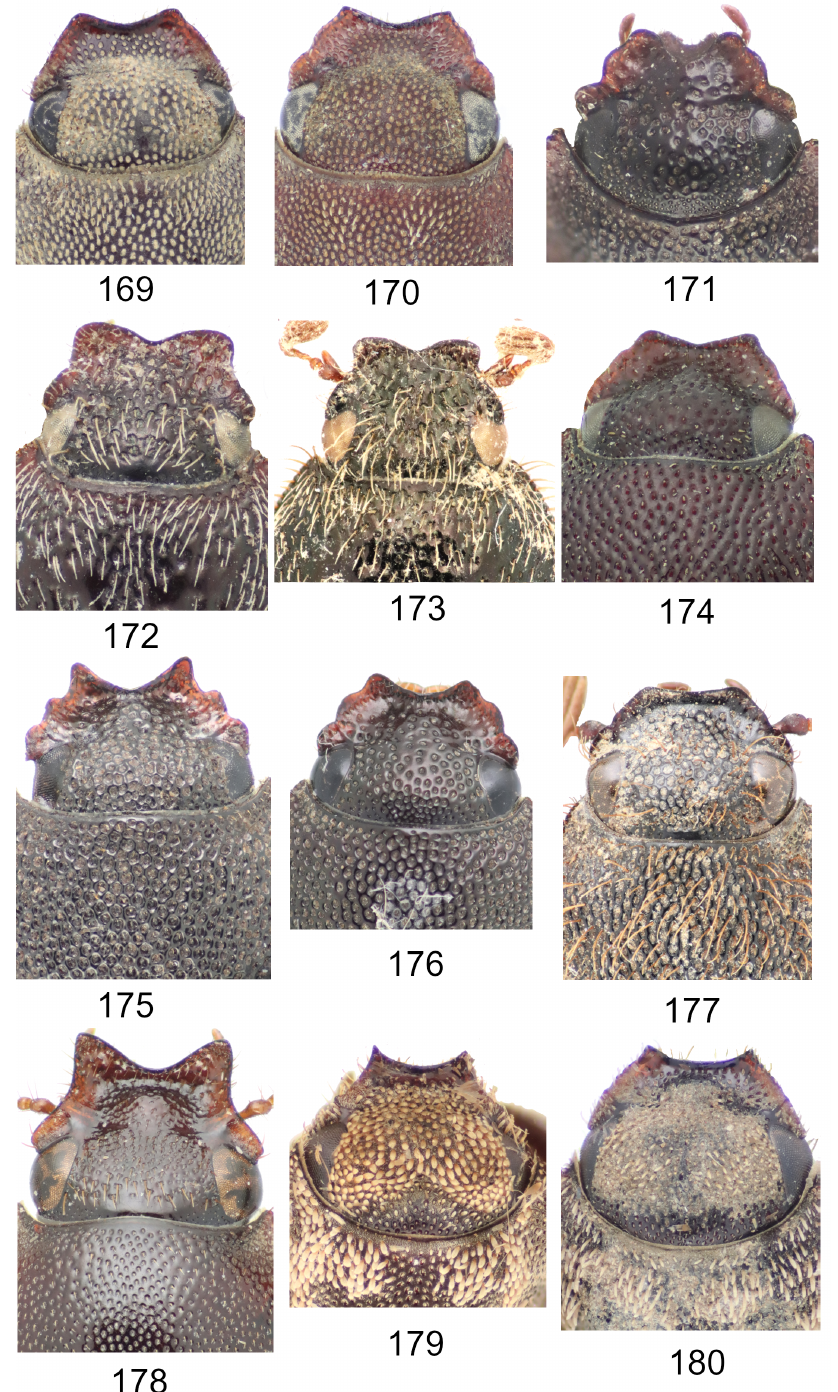
Figs 169–180. Papuan and Wallacean Maechidius Macleay, 1819, head, dorsal view. 169 . M. popei (Frey, 1969) comb. nov., holotype, ♀ (BMNH). 170 . Same, paratype, ♂ (BMNH). 171 . M. seriegranosus Heller, 1914, lectotype, ♂ (SNSD). 172 . M. rugicollis Moser, 1920, lectotype, ♀ (ZMHB). 173 . Same, ♂ (ZMHB). 174 . M. seriepunctatus Moser, 1920, lectotype, ♂ (ZMHB). 175 . M. similis sp. nov., paratype, ♂ (BMNH). 176 . Same, paratype, ♀ (BMNH). 177 . M. skalei sp. nov., paratype, ♂ (NME). 178 . M. sougb sp. nov., holotype, ♂ (NME). 179 . M. speciosus (Frey, 1969) comb. nov., ♂ (NHMB). 180 . Same, ♀ (BMNH). Not to